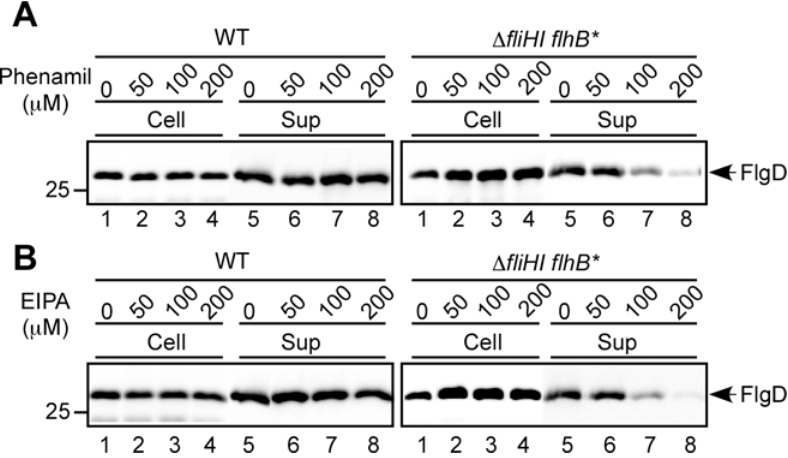
Fig 3. Effect of Na + channel blockers on FlgD level secreted by wild-type cells (left panels) and the Δ fliH-fliI flhB(P28T) bypass mutant cells (right panels). Immunoblotting, using polyclonal anti-FlgD antibody, of whole cell proteins (Cells) and culture supernatant fractions (Sup) prepared from SJW1103 (WT) and MMHI0117 ( Δ fliHI flhB * ) grown exponentially at 30°C in T-broth containing 100 mM NaCl with 0 μ M, 50 μ M, 100 μ M or 200 μ M (A) phenamil or (B) EIPA at an external pH of